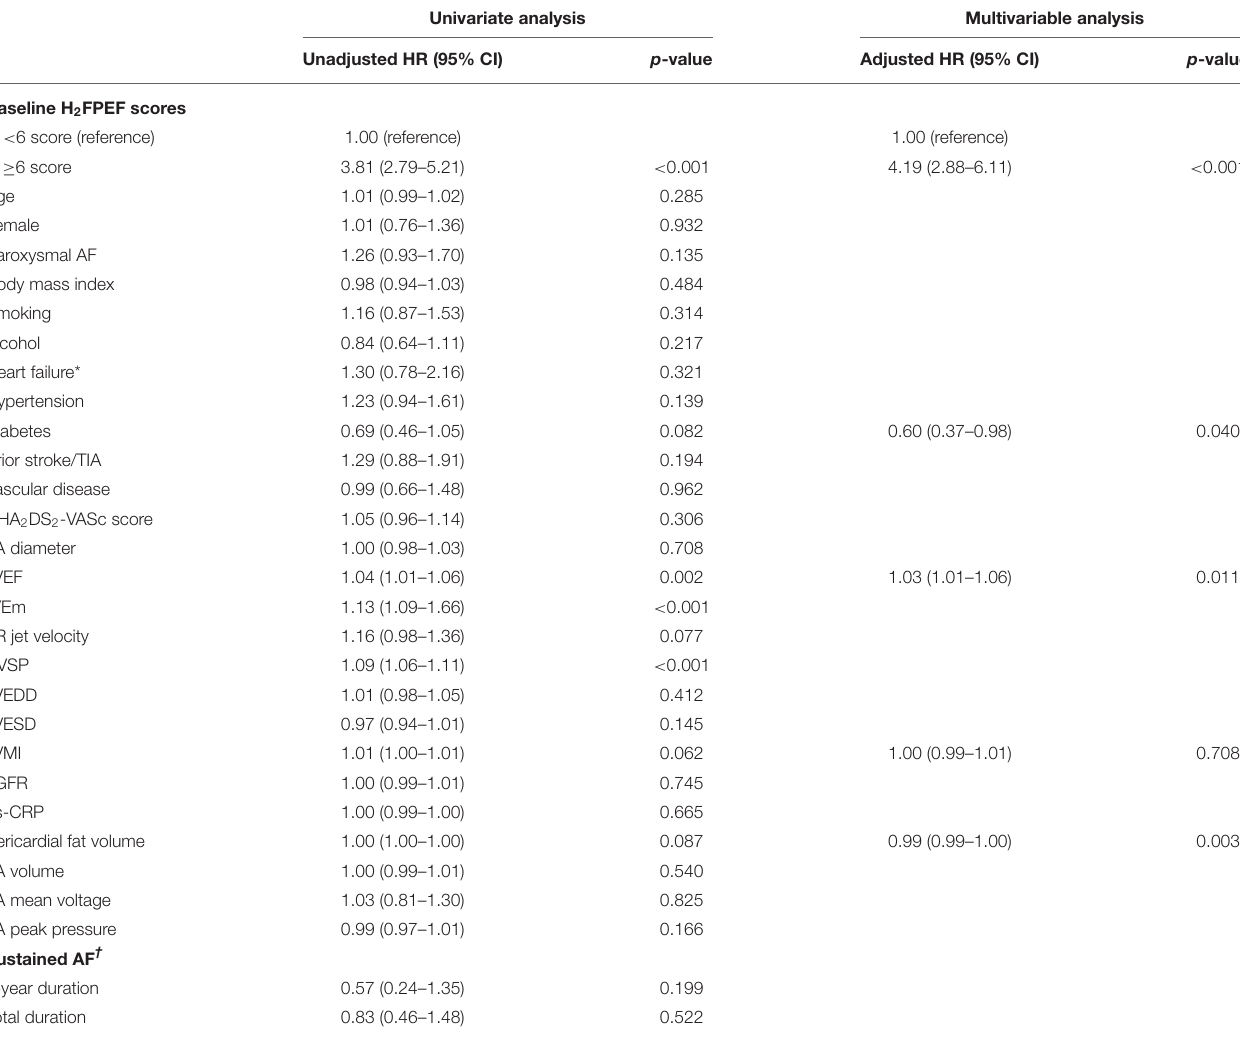
TABLE 3 | Logistic regression analysis for predictors of decreased H 2 FPEF scores, 1-year after the AFCA. Univariate analysis Multivariable analysis